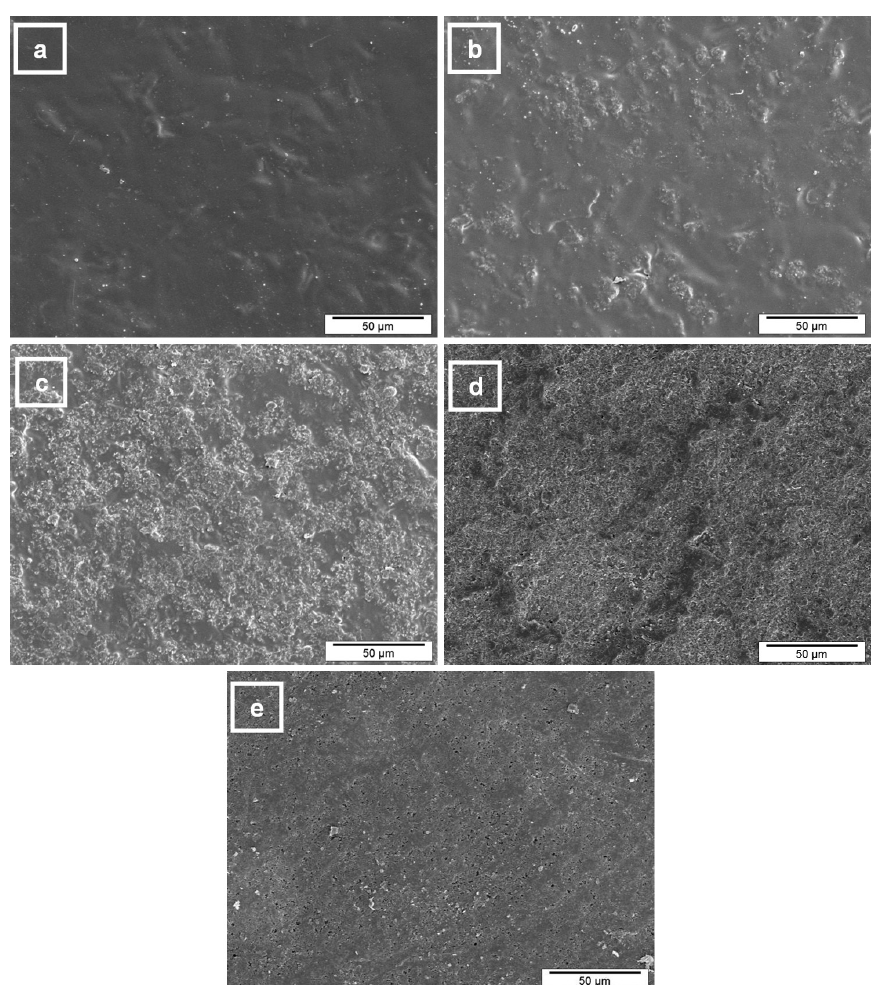
Figure 2. Micrographs of coatings from: (a) pure PMMA; (b) 90%PMMA-10%hBN; (c) 70%PMMA-30%hBN; (d) 50%PMMA-50%hBN; (e) 30%PMMA-70%hBN, on stainless